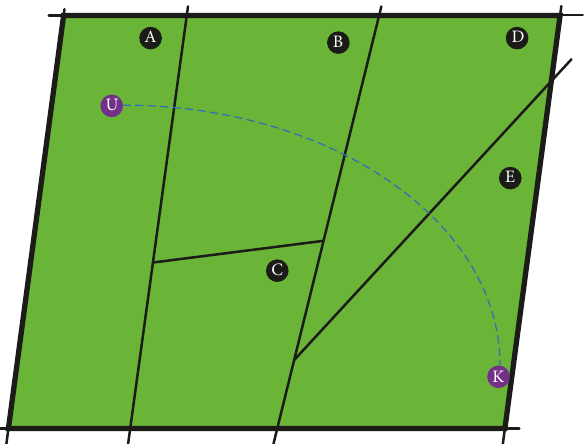
Figure 2: The schematic of a multi-region urban network and a path